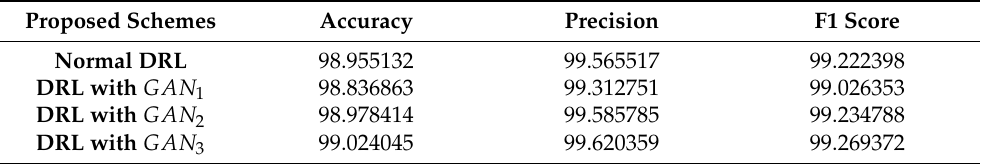
Table 5. Performance evaluation of multi-class classification for different